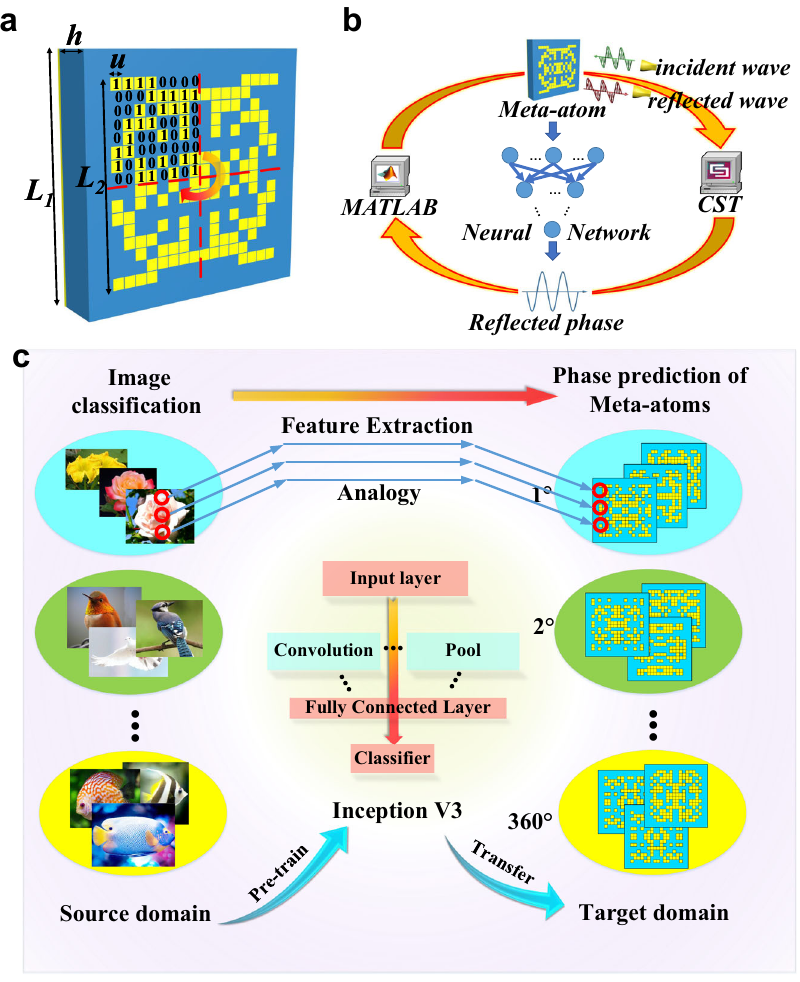
Fig. 2 The design process of transfer learning network. a Discretization and coding of the meta-atom pattern. b The process of collecting data that based on MATLAB-CST co-simulation. c Schematic illustration of the general architecture of transfer learning, which links image recognition and phase Operation System. The GPU con fi guration is NVIDIA GeForce GTX 1060 with Max-Q Design/6GB.